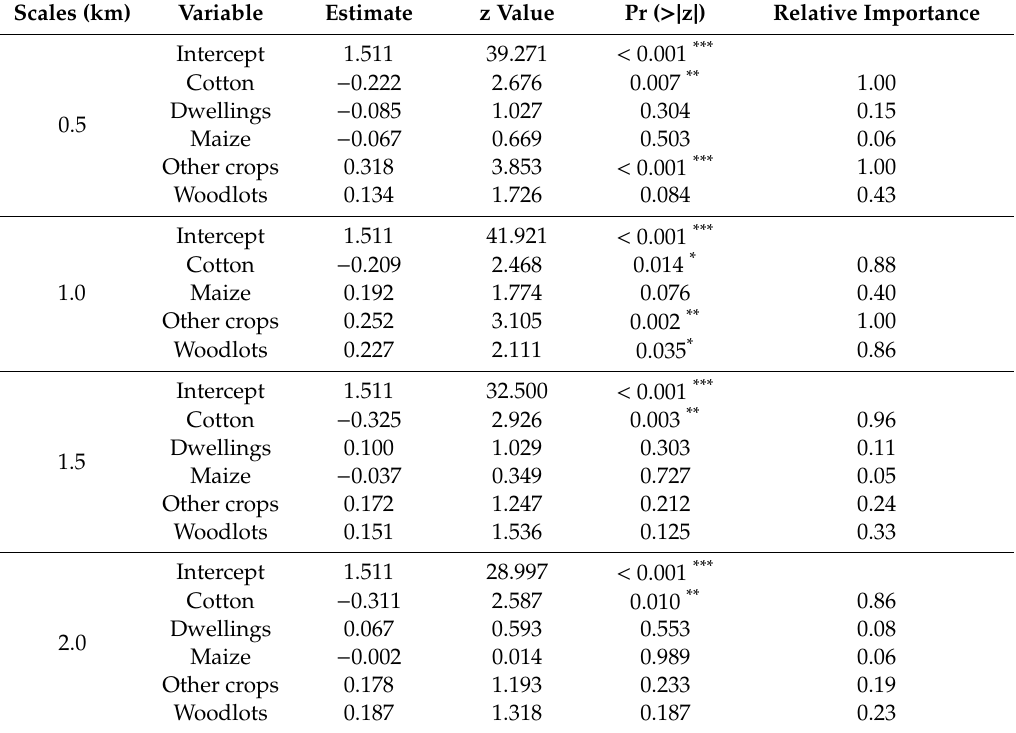
Table 2. Results of model averaging procedure to estimate landscape e ff ects on abundance of